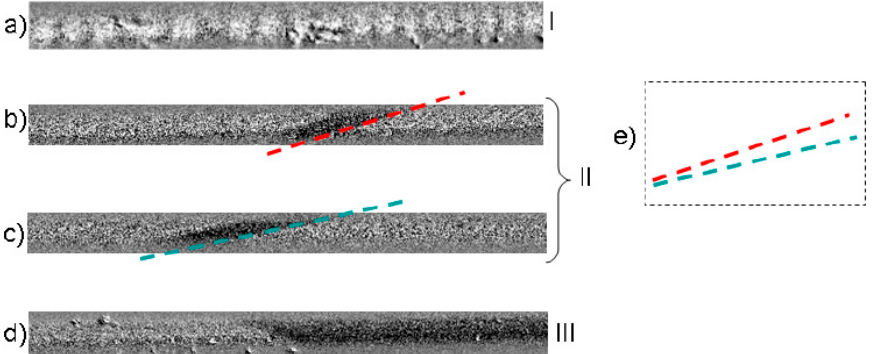
Figure 5. Images of di ff erent domain structures obtained in the presence of stress observed for di ff erent amplitude of torsion τ : ( a ) 0 π radm − 1 , ( b ) 20 π radm − 1 , ( c ) 30 π radm − 1 , ( d ) 40 π radm − 1 ; ( e ) schematically images of spiral structures. Reprinted with permission from [17].